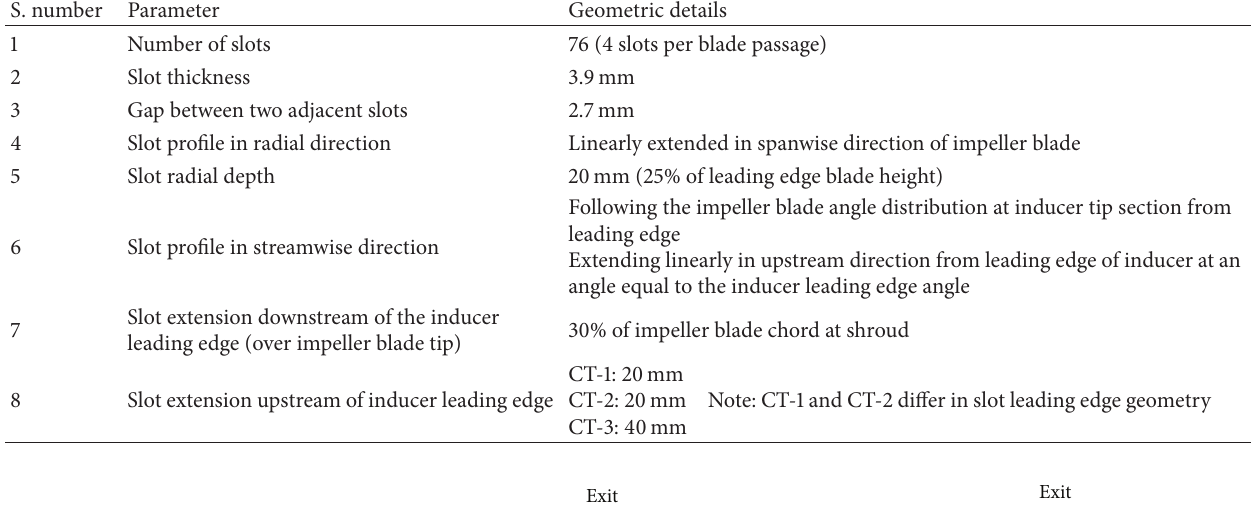
Table 2: Geometry details of casing treatment configurations.